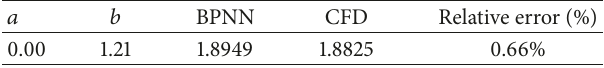
Table 4: Comparisons of the optimal drag ratio of the AUV fleet between CFD and BPNN.